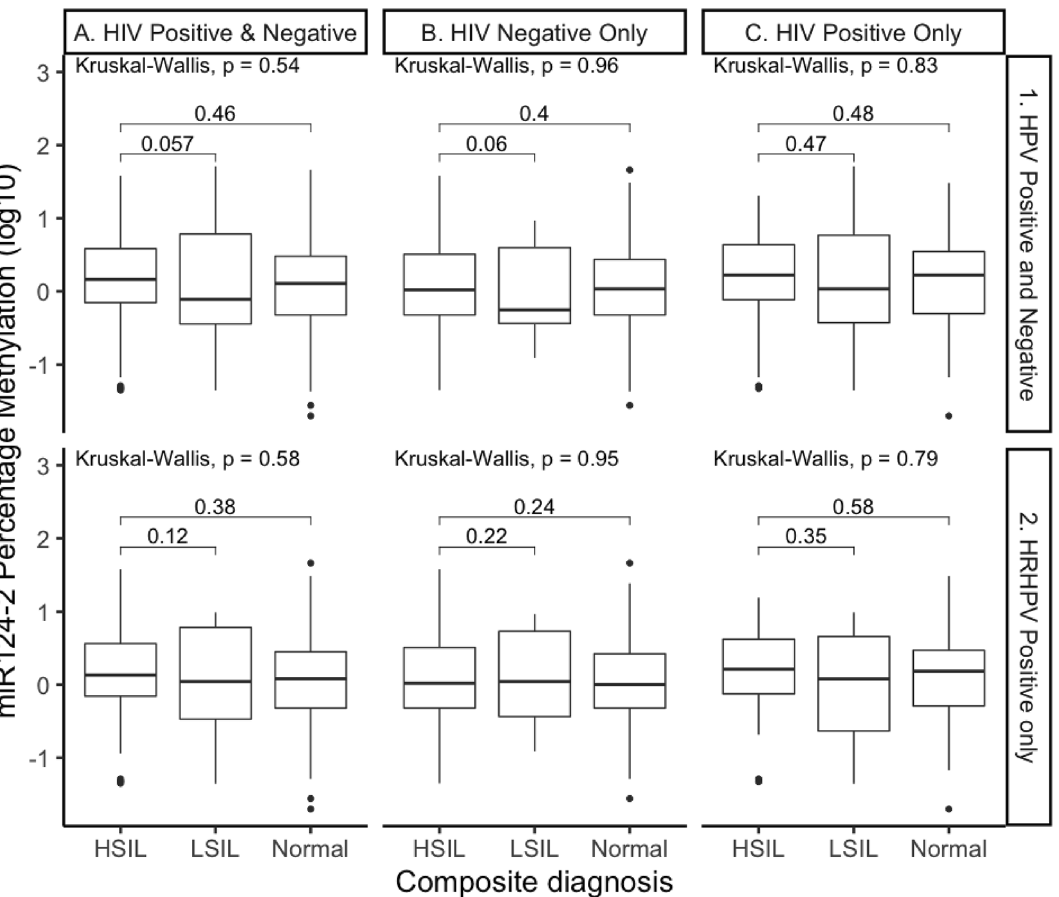
Figure 5. Percentage Methylation of gene miR124-2 . All samples represented by HRHPV positivity and HIV status. Comparisons assessed by the nonparametric Wilcoxon test, with error bars corresponding to the first and third quartiles (the 25th and 75th